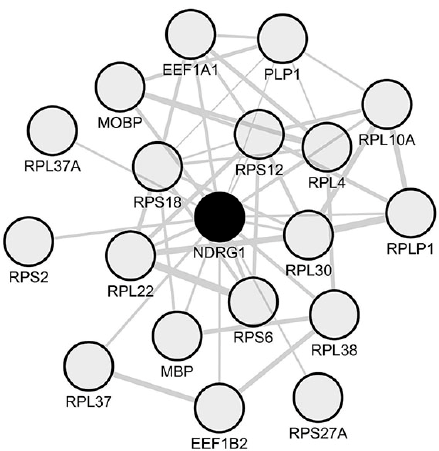
Figure 6. Oligodendrocyte signature inferred from the NDRG1 co-expression module in spinal cord periplaques. To identify an oligodendrocyte molecular signature in spinal cord periplaques, we used the oligodendrocyte-specific hub gene NDRG1 ( N -myc downstream regulated 1) as a “bait” and retrieved the top-200 mRNA species that most closely co-downregulated with NDRG1 . The co-expression network formed by functionally-relevant genes is shown. Genes are designated by their gene symbols. Gene full names are provided in Table 3. Table 3. List of functionally-relevant genes that co-express with NDRG1 in spinal cord periplaque areas.